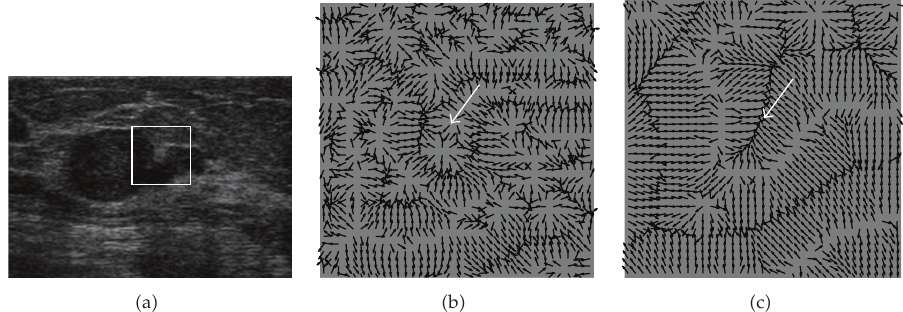
Figure 4: Comparison between original GVF field (cid:3) Niter (cid:8) 10 (cid:4) and improved GVF (cid:3) Niter (cid:8) 10 (cid:4) of the breast US image. (cid:3) b (cid:4) and (cid:3) c (cid:4) are zoomed-in views of the original GVF and improved GVF in square window marked in (cid:3) a (cid:4) . As shown by the arrows, more gradient vectors in the improved GVF field point to the true